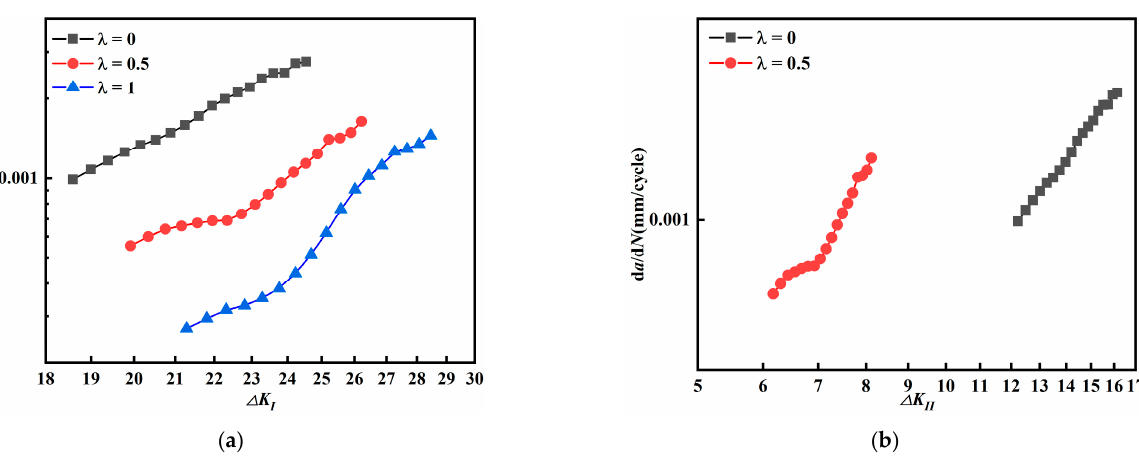
Figure 10. Relationship between stress intensity factor amplitude △ K I , △ K II , and da/dN ( β = 60°). ( a ) Relationship between △ K I and da/dN . ( b ) Relationship between △ K II and da/dN .